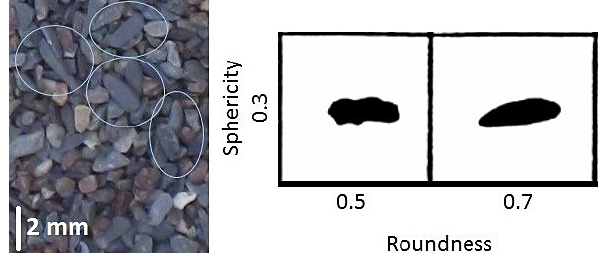
Figure 2. Left panel: example of flat, elliptic sand particles. Right panel: particle shapes which reached the highest friction angles in the study of Cho et al. (2006) (modified after Santamarina and Cho,